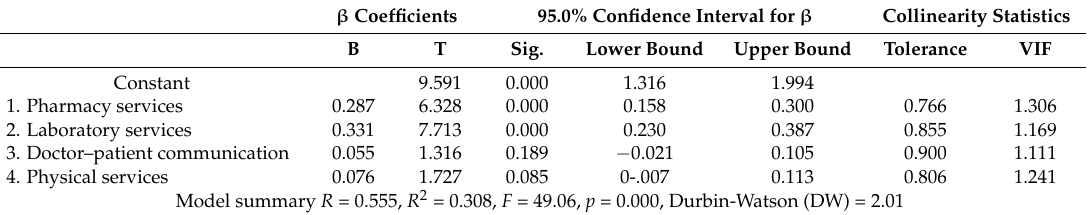
Table 8. Multiple regression models (dependent variable: Patient